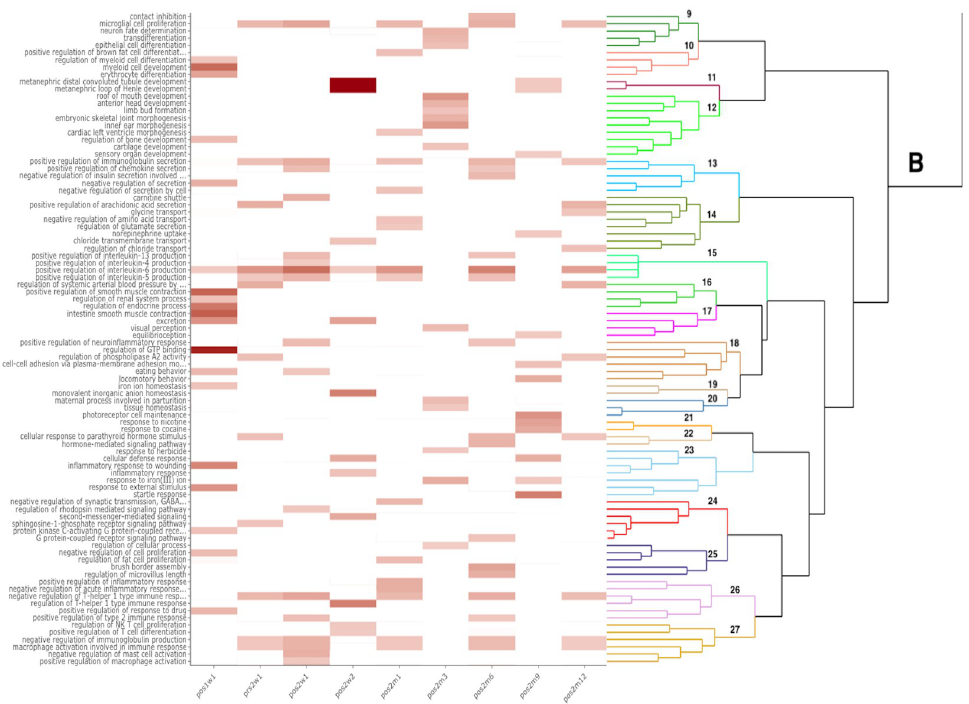
Fig 6. A heat map showing the clustering of GO biological process terms. Branch B refers to the second main branch identified when hierarchical clustering was performed based on the semantic similarity between GO terms. Clusters are labeled 9–27, starting at the top. The color of the cell corresponds to the associated p-value from the enrichment analysis. Multiple processes related to inflammation and bone-remodeling were identified at multiple time points throughout the